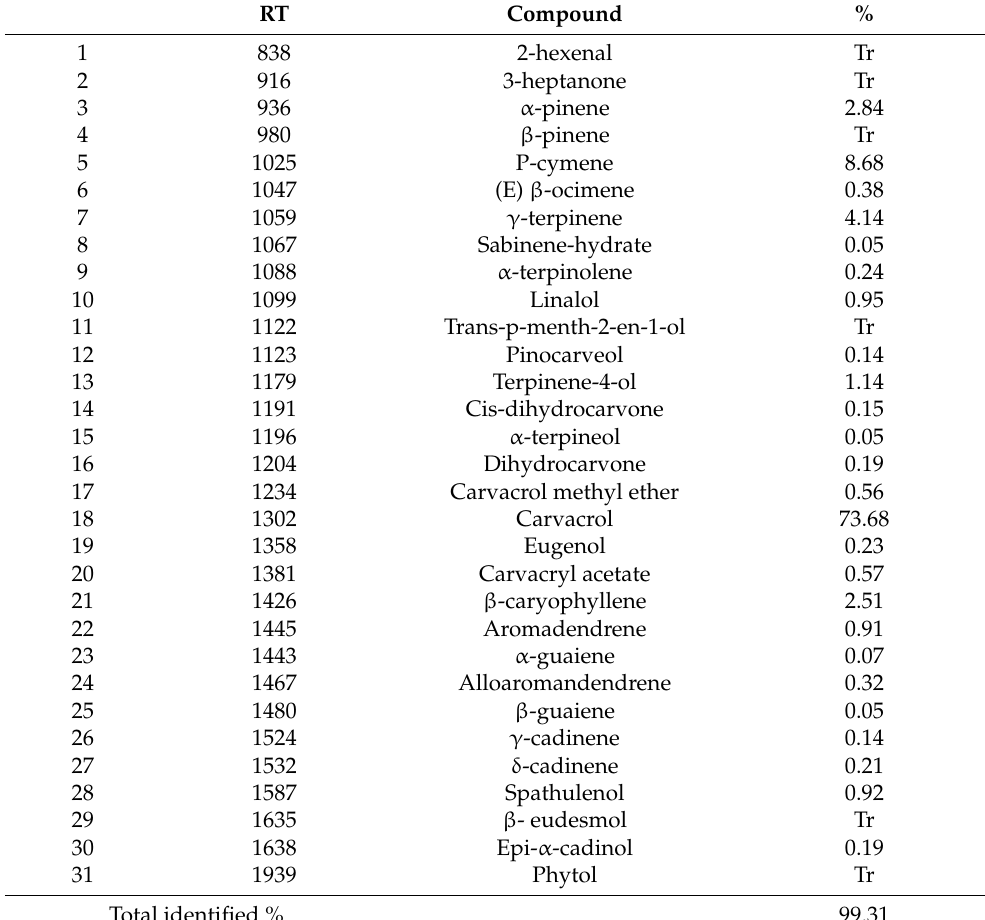
Table 1. Chemical compounds obtained from the essential oil of Thymus leptobotrys